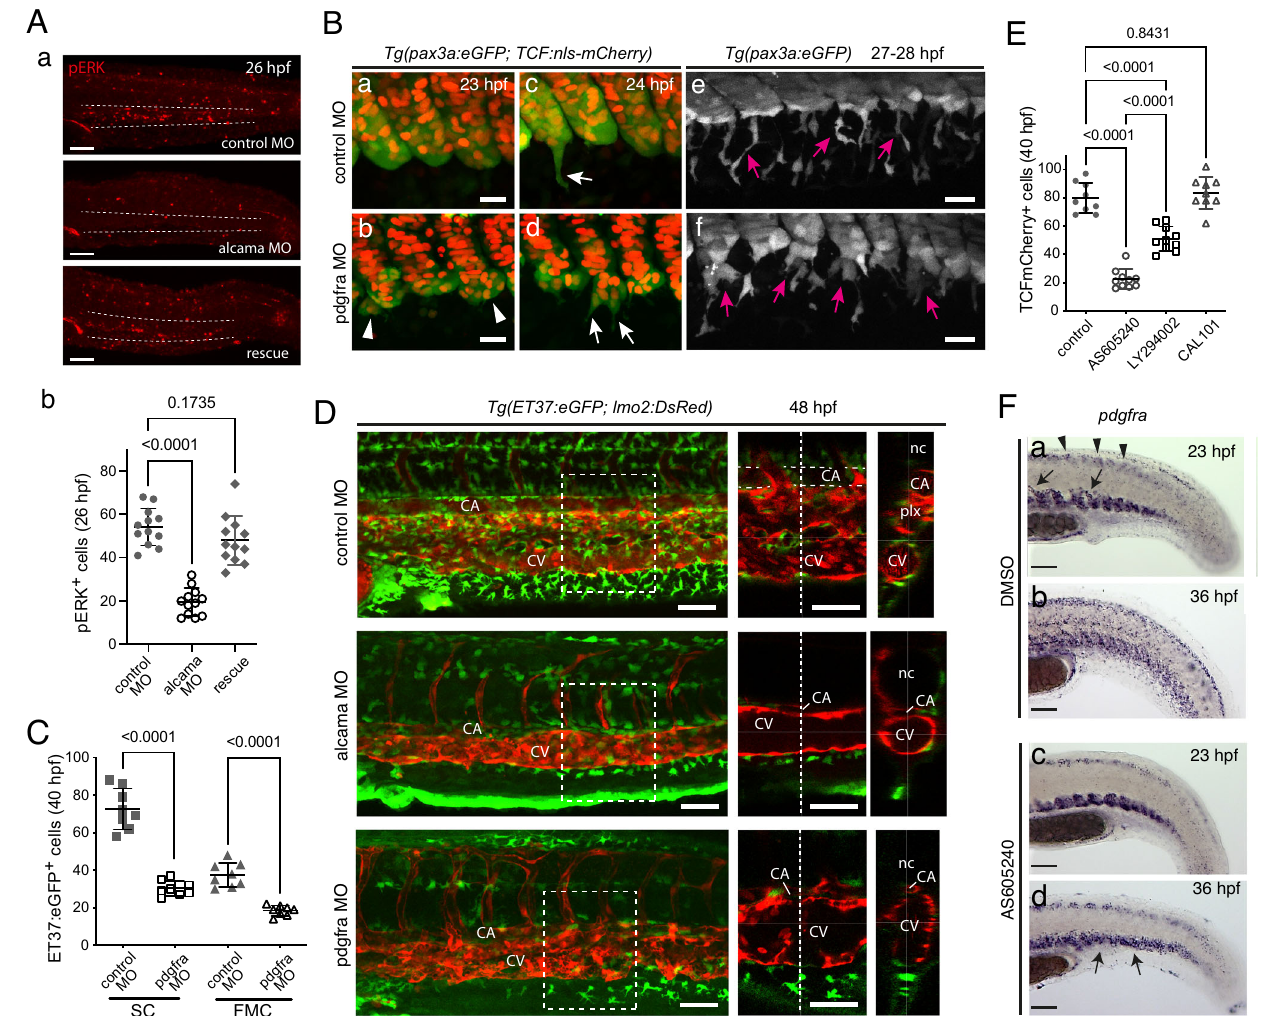
Fig. 3 | Pdgfr- α /PI3K signaling regulates SCP migration. A ( a ) Immuno- fl uorescence for pERK at 26 hpf in the tail region of embryos injected with control MO,alcamaMO,oralcamaMO+alcamamRNA( “ rescue ” ); n =12embryosfromtwo independent experiments. Dashed lines indicate the CHT border. b Quanti fi cation of a ( n =12 embryos for each group; mean±SD; one-way ANOVA followed by Dunnett ’ smultiplecomparisontest). B Confocalprojectionsof livecontrol( a , c , e ) or pdgfra( b , d , f )MO-injected Tg(ET37:eGFP;TCF:nls-mCherry) embryos from 23to 28 hpf. Arrowheads point at cohesion defects observed in the VCs of pdgfra MO- injected embryos. White and magenta arrows indicate emerging ( c , d ) and migrating( e , f )SCPs,respectively; n =9foreachconditionfromthreeindependent experiments. Scale bars, 25 µ m. C Quanti fi cation of ET37:eGFP + stromal cells and FMCs in control and pdgfra MO-injected embryos at 40 hpf ( n =8 for each group, from the same experiment; mean±SD; two-tailed Student ’ s t -test). D Confocal maximum projections of control, alcama, and pdgfra MO-injected Tg(ET37:eGFP;